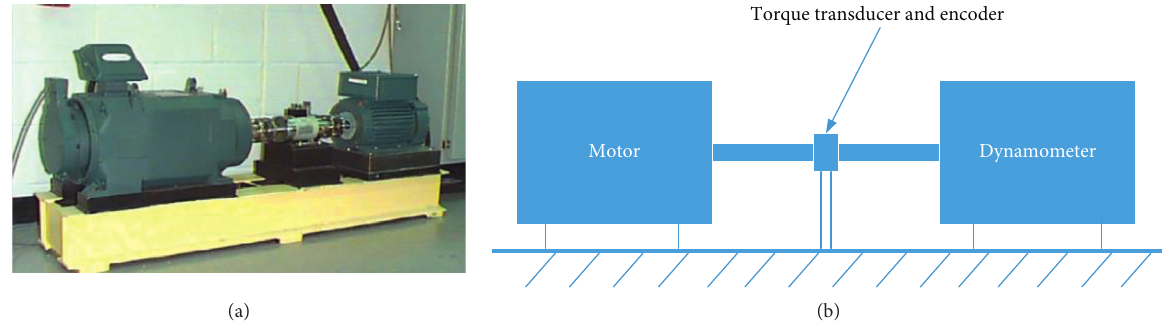
Figure 5: CWRU experimental platform: (a) the physical and (b) the schematic